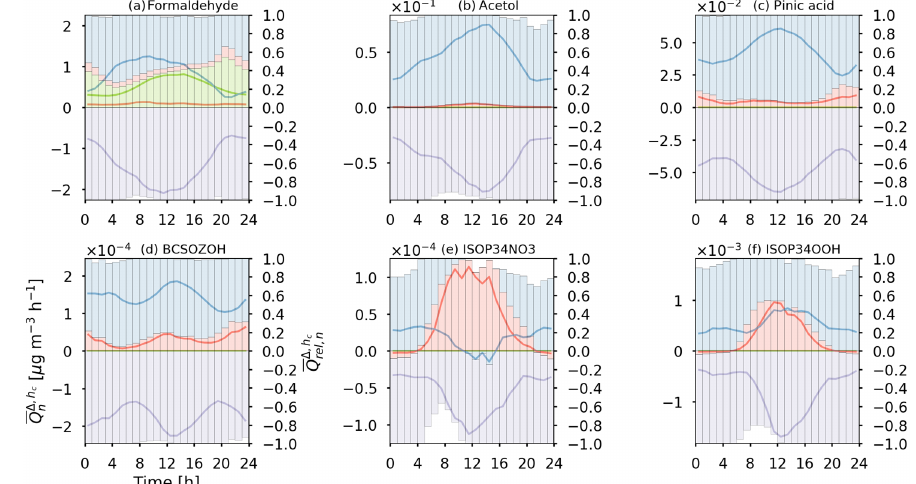
Figure 7. The same as Fig. 6 but for (a) formaldehyde, (b) acetol, (c) pinic acid, (d) BCSOZOH, (e) ISOP34NO3, and (f)